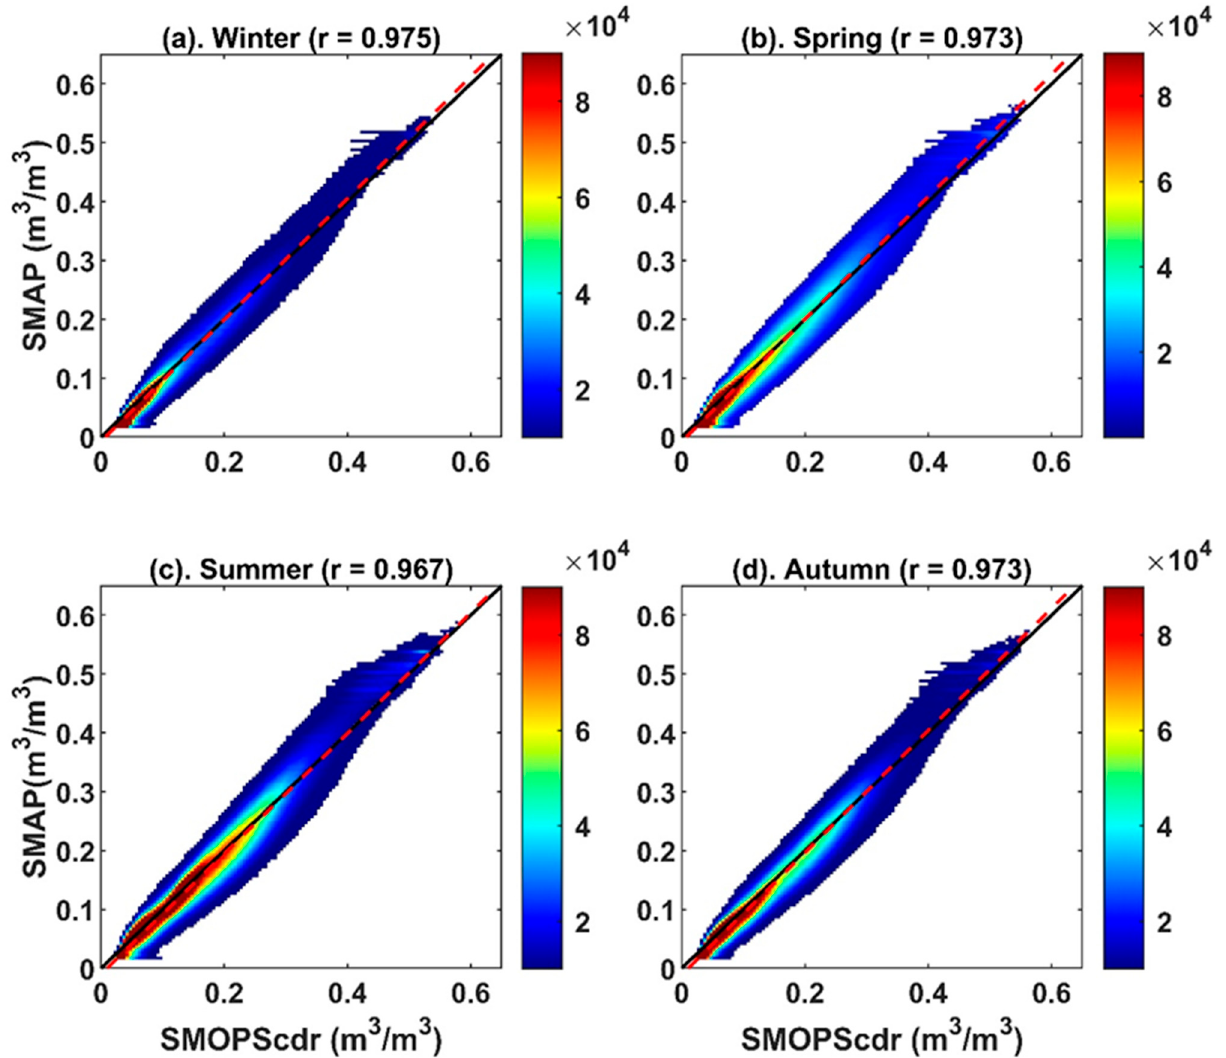
Figure 2. The daily SMAP versus the daily SMOPScdr soil moisture data over the global domain from 1 April 2015 to 30 August 2021: ( a ) Winter, December–January–February; ( b ) Spring, March– April–May; ( c ) Summer, June–July–August; and ( d ) Autumn, September–October–November. The black diagonal line represents they are perfectly matched. The red dashed line from the low-left to the upper-right is their linear regression curve. The color bar indicates sample density.